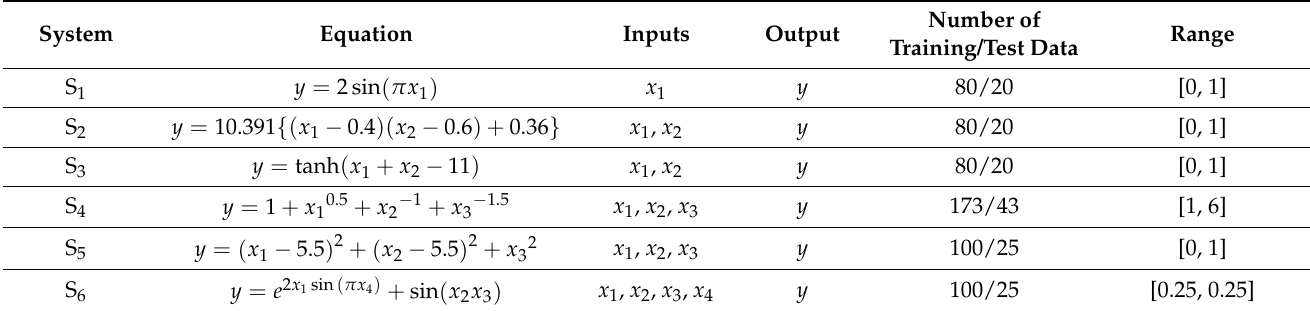
Table 5. Information on the nonlinear static systems used.